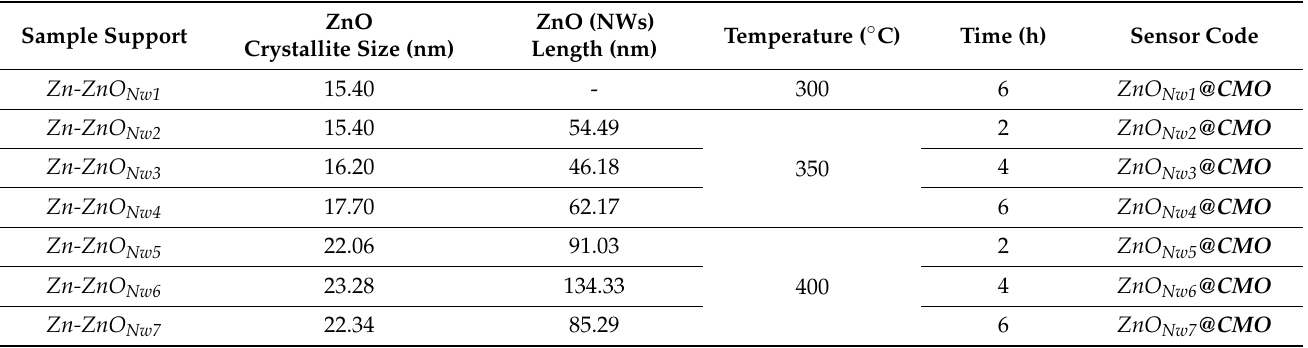
Table 1. The working parameters for the thermal oxidation of the Zn foil, ZnO crystallite sizes, the average length of ZnO NWsand sensor code.